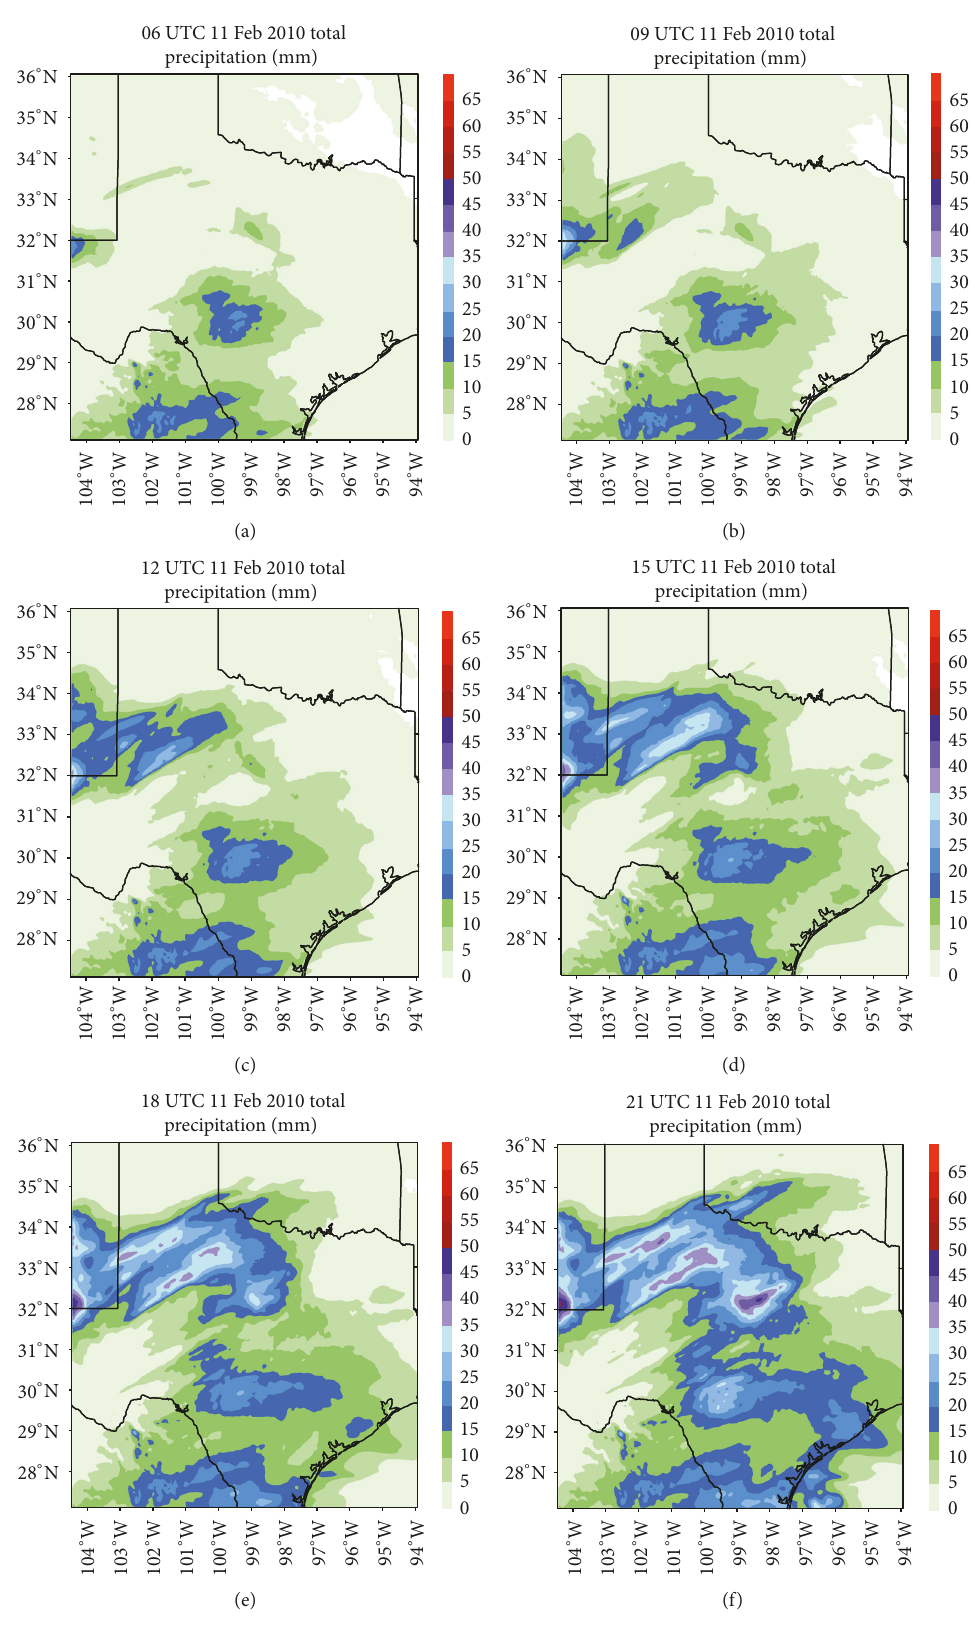
Figure 13: Simulated (4km) total precipitation (mm) accumulated in 3-hourly intervals on (a) 0600, (b) 0900, (c) 1200, (d) 1500, (e) 1800, and (f) 2100 UTC 11 February